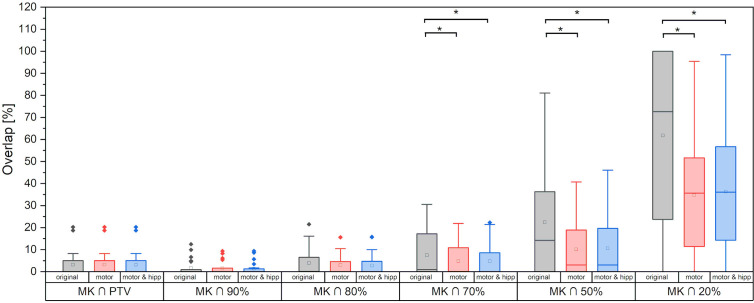
Motor cortex volume included inside planning target volume (PTV) and different relative isodose lines. Statistically significant differences are denoted by asterisk.